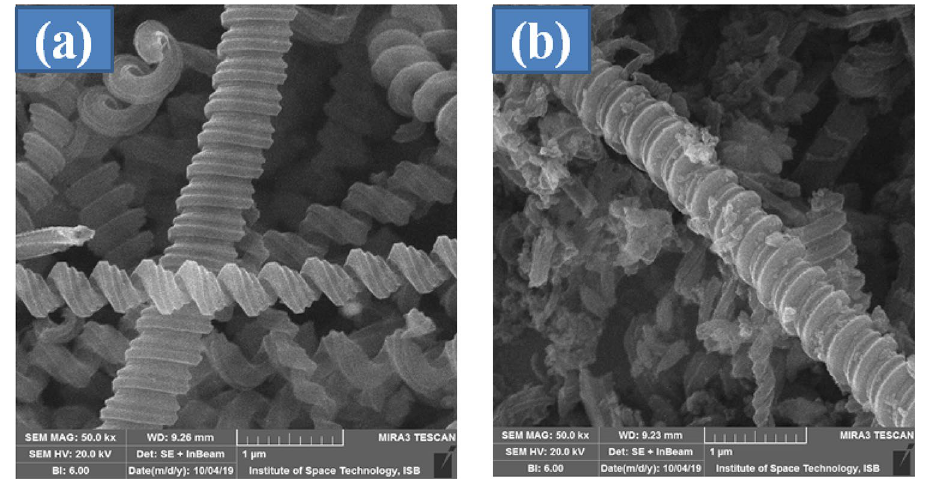
Figure 4. Scanning electron microscopic images of ( a ) pure CNCs and ( b ) CNCs/Zn-TPP.